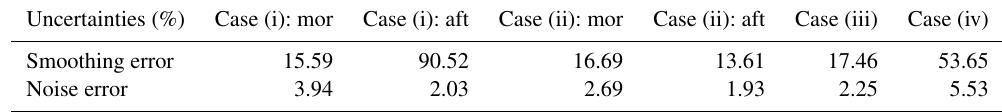
Table 5. The MAX-DOAS average smoothing and noise errors (%) for each case